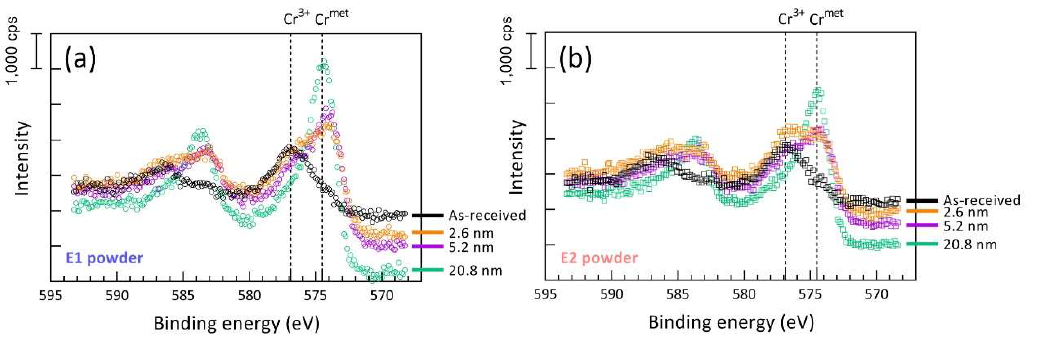
Figure 5. XPS narrow scans over the energy regions for Cr2p for ( a ) virgin and ( b ) reused powder, showing higher fraction of Cr in an oxide state in the case of the reused powder at all etch depth.